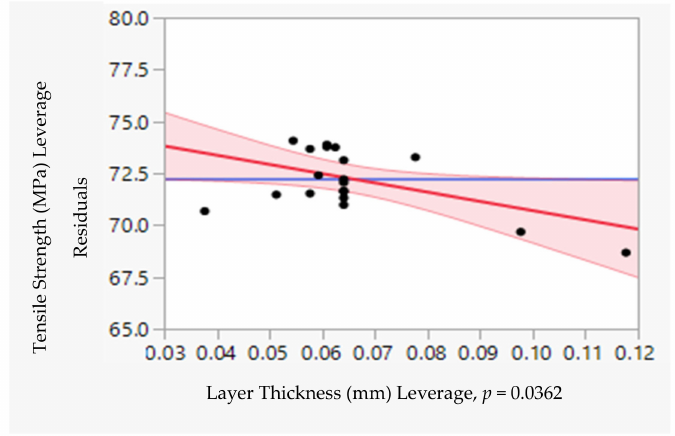
Figure 13. Tensile strength vs. layer thickness.